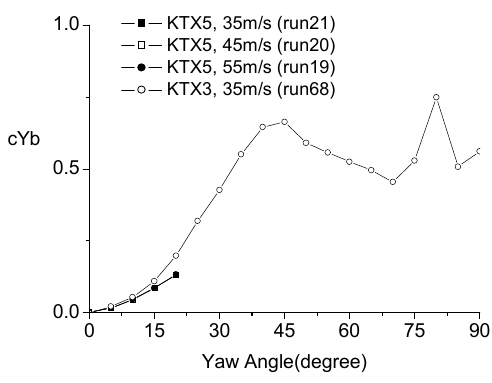
Figure 8 Side force coefficient (KTX T3-car)